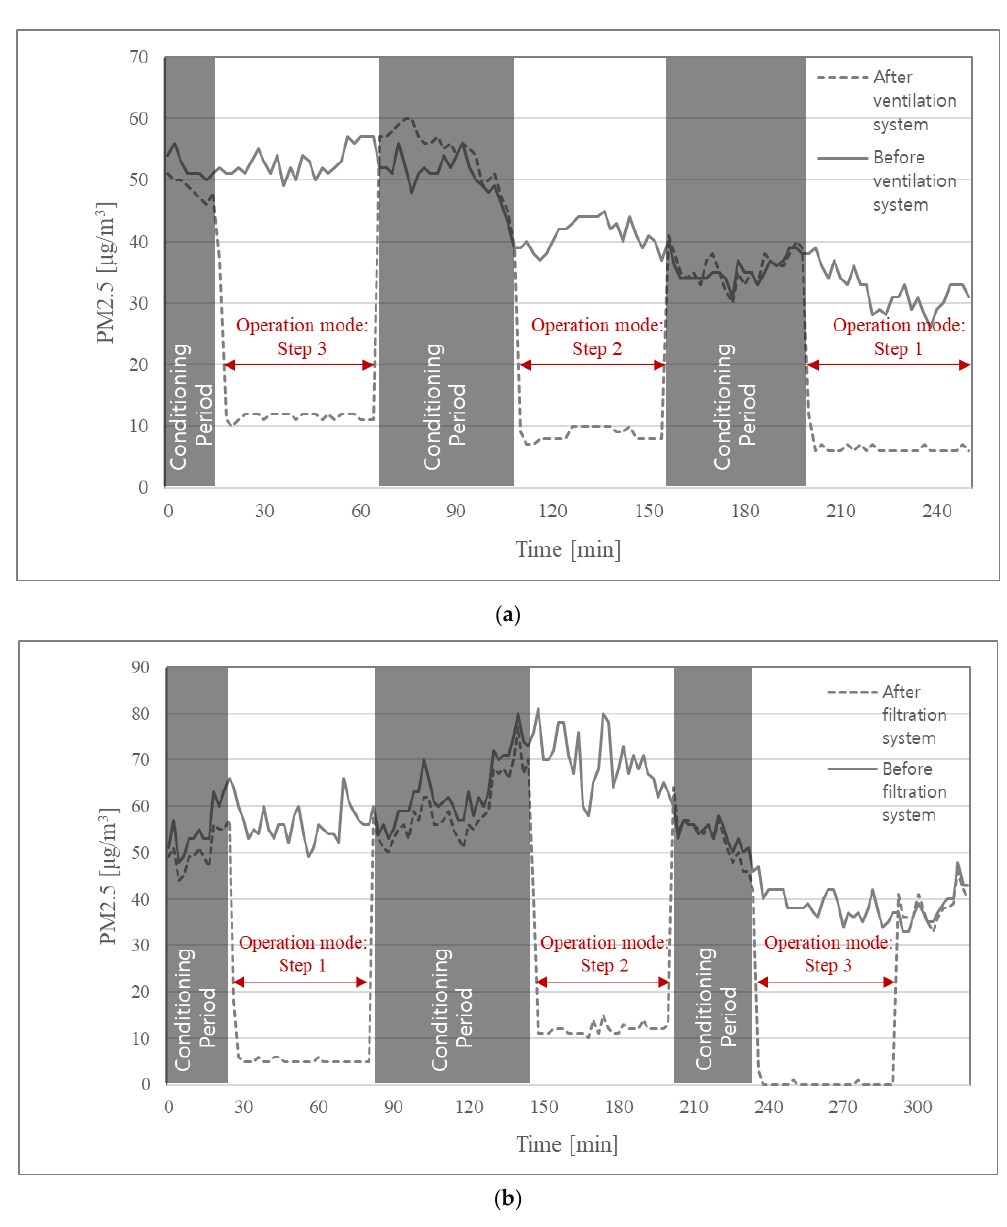
Figure 6. Measured data to obtain filter efficiency of ( a ) ventilation system and ( b ) filtration system. Table 4. Results of parameters 𝜂 𝑣 and 𝜂 𝑓 according to the flow rate.